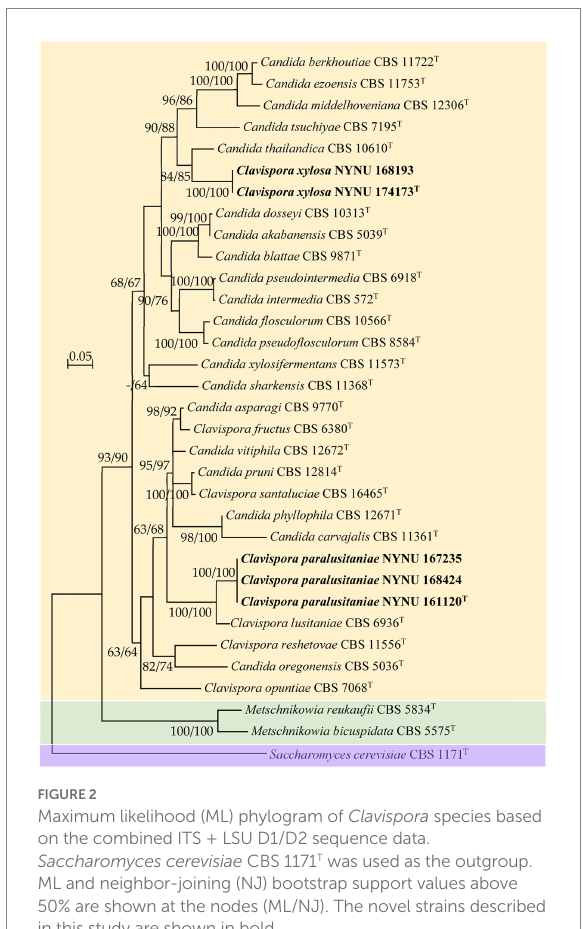
FIGURE 2 Maximum likelihood (ML) phylogram of Clavispora species based on the combined ITS + LSU D1/D2 sequence data. Saccharomyces cerevisiae CBS 1171 T was used as the outgroup. ML and neighbor-joining (NJ) bootstrap support values above 50% are shown at the nodes (ML/NJ). The novel strains described in this study are shown in bold.